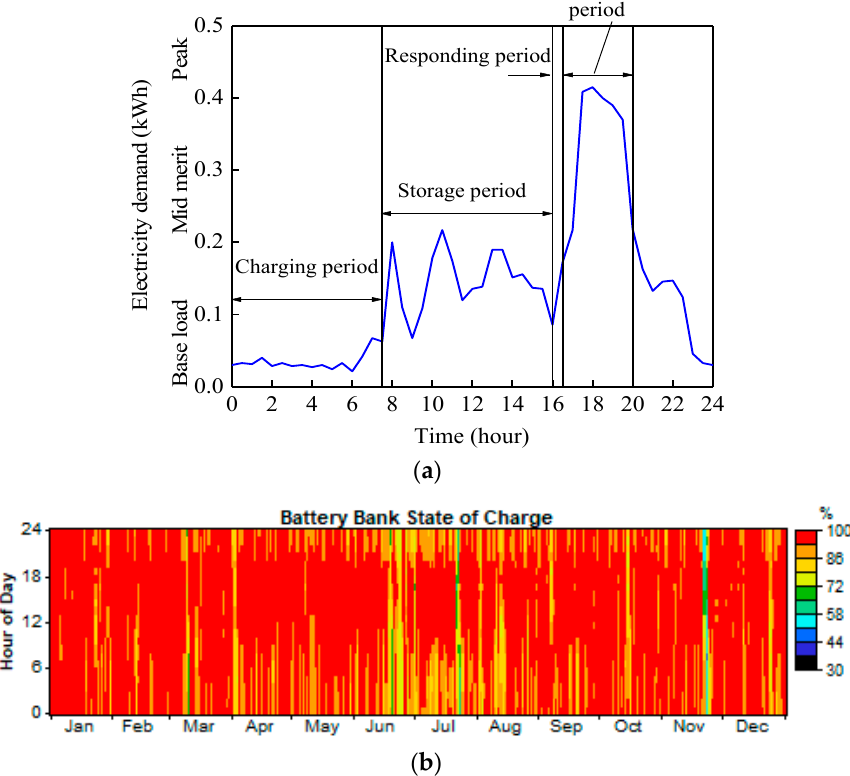
Figure 8. Daily load profile for energy storage system: ( a ) daily load and ( b ) state of charge of batteries. The battery charging could be calculated by Equation DC and AC Converter